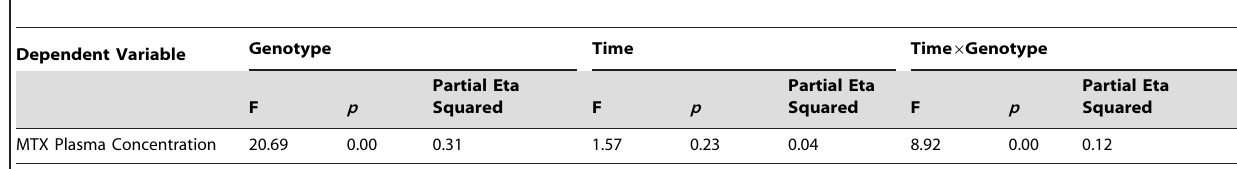
Table 3. Effects of ATP-binding cassette subfamily C member 2 ( ABCC2 ) gene 2 24C . T genotype and time on methotrexate (MTX) plasma